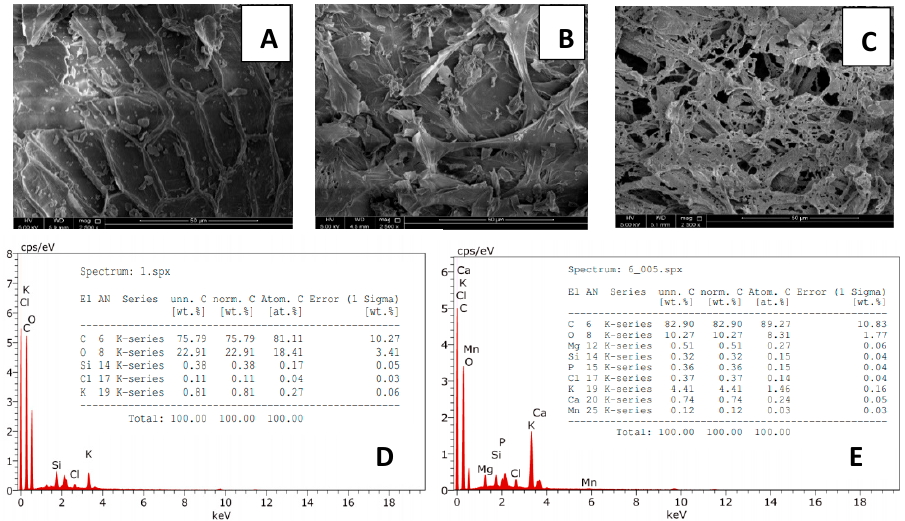
Figure 7. The upper panel is the SEM micrographs of RPAL ( A ), TTPAL250 ( B ), and TTPAL500 ( C ). The lower panel is the EDX analysis of RPAL ( D ), and TTPAL500 ( E ).